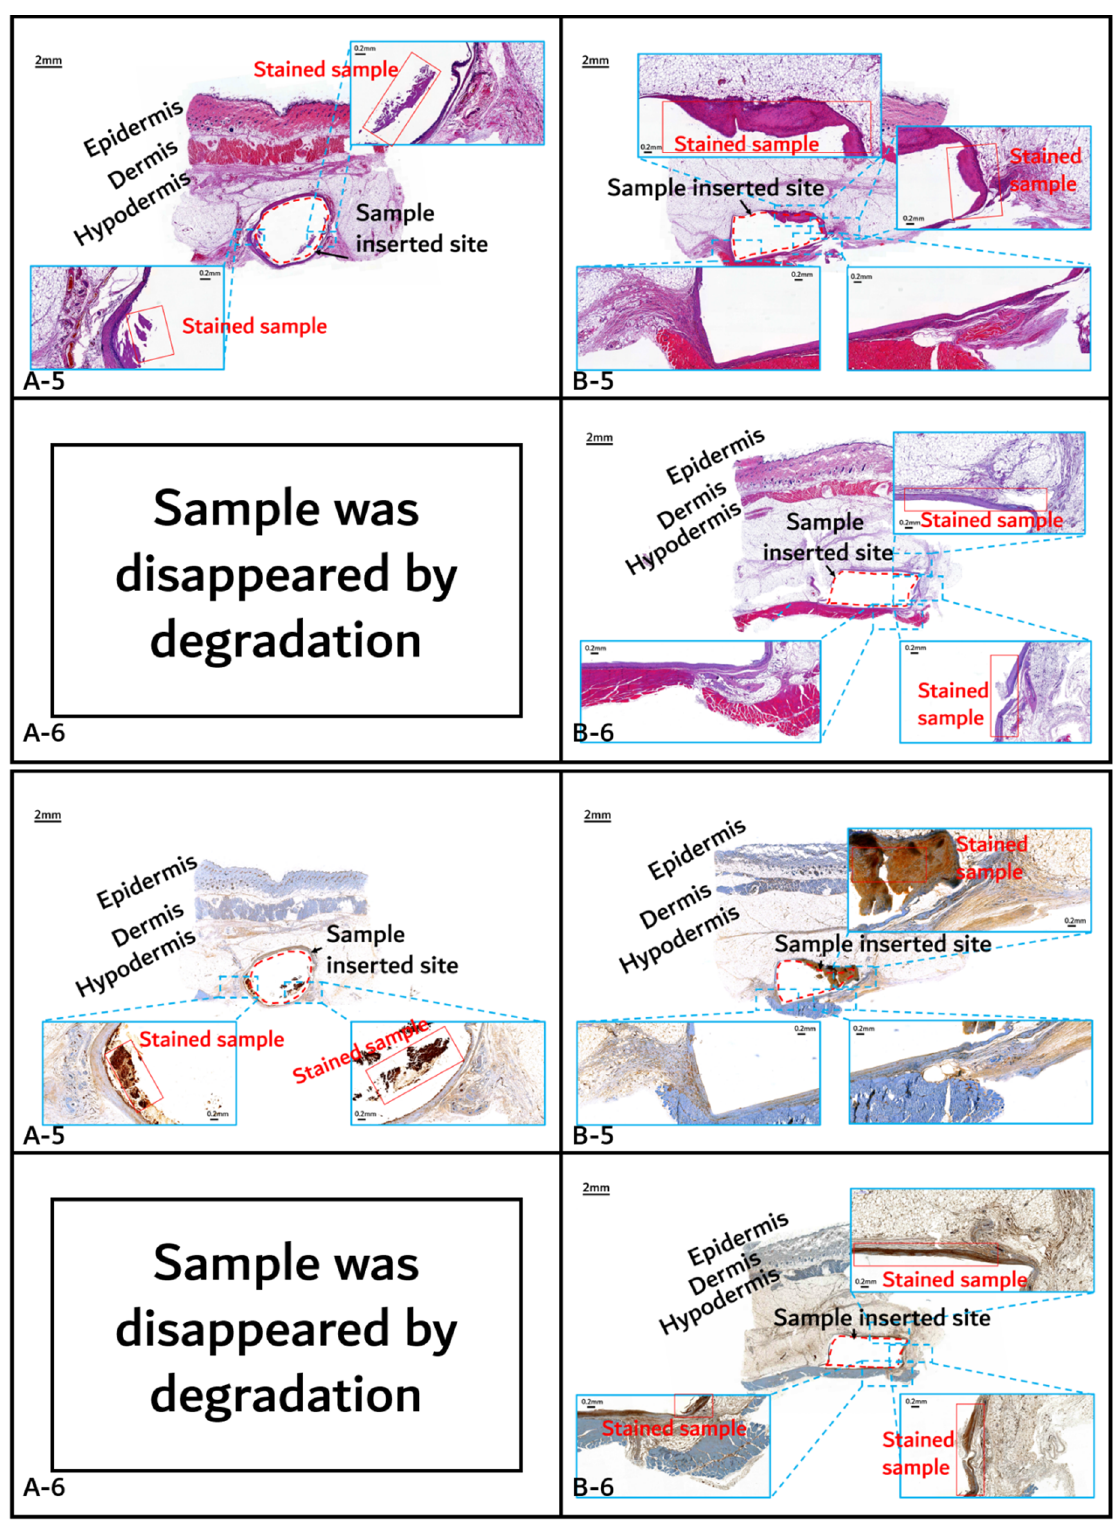
Figure 13. Histochemical analysis (upper: H&E staining, below: immunostaining) of in vivo animal degradation test. ( A-5 , 6 : tissue around a PLGA sample which 5 and 6 months after insertion, B-5 , 6 : tissue around a PGA–PLA block copolymer sample that was inserted at 5 and 6 months). Initial granulomatous inflammation and fibrous encapsulation were observed at an early stage of insertions up to 2 months (Figure 11). This phenomenon was closely relat- ed to rapid surface swelling (leading to surficial erosion and hydrolysis) by water ab-